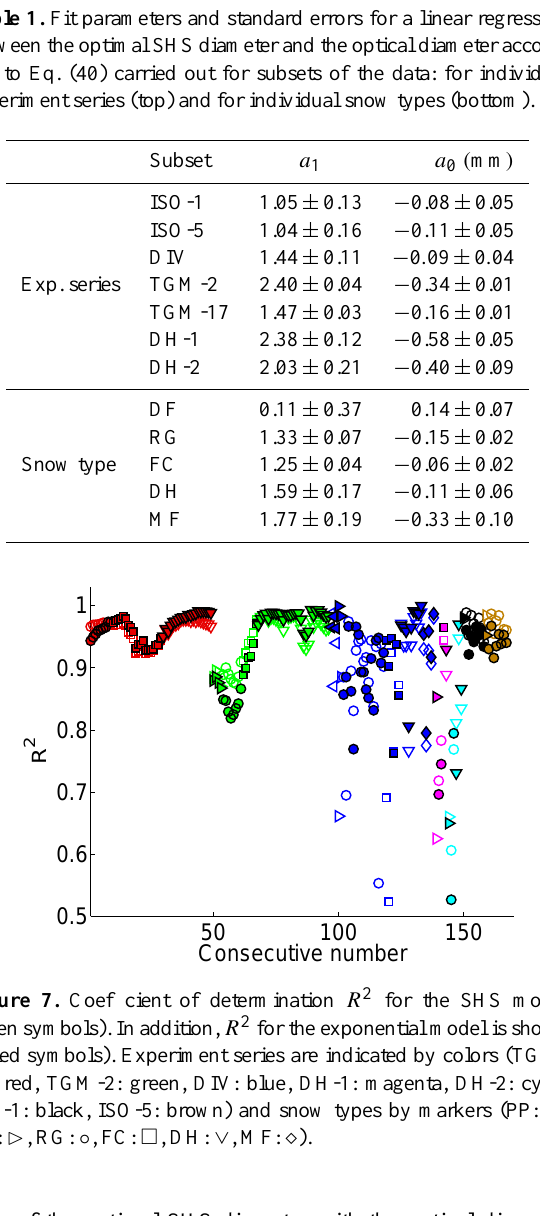
ison of the optimal SHS diameter with the optical diameter from Fig.